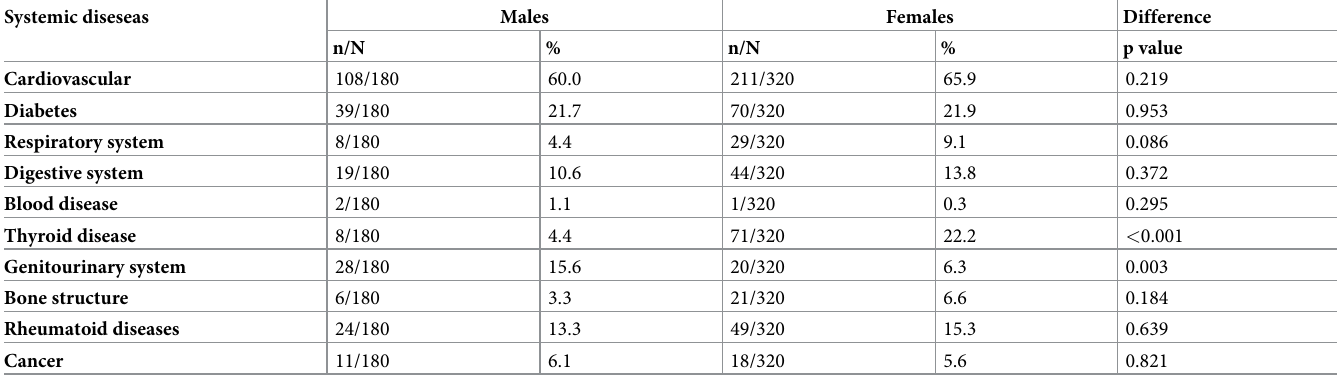
Table 2. Frequency of systemic diseases.